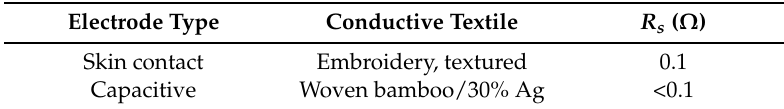
Figure 2. Photos showing partial views of inner layer from two versions of T-shirts; ( a ) with non-removable embroidery electrodes; ( b ) with snap fasteners; and ( c ) a photo of removable embroidery electrodes. Table 1. Characteristics of textile materials used in sensors.